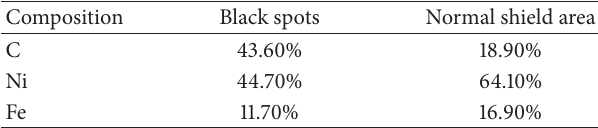
Table 1: Auger electron spectroscopy (AES) data for black